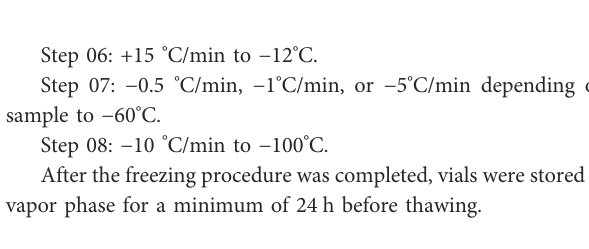
concentration to achieve a fi nal concentration of 1%, 5%, and 10% DMSO. The addition of cryoprotection solutions occurred at room temperature and the cells were incubated for 30 min before freezing. A controlled-rate freezer (Kryo 560, Planer, Middlesex, UK) was used for freezing samples with a plunge (Steps 4 – 6) to induce nucleation around − 4 ° C to re fl ect the same conditions performed under Raman spectroscopy. The freezing protocol used is given